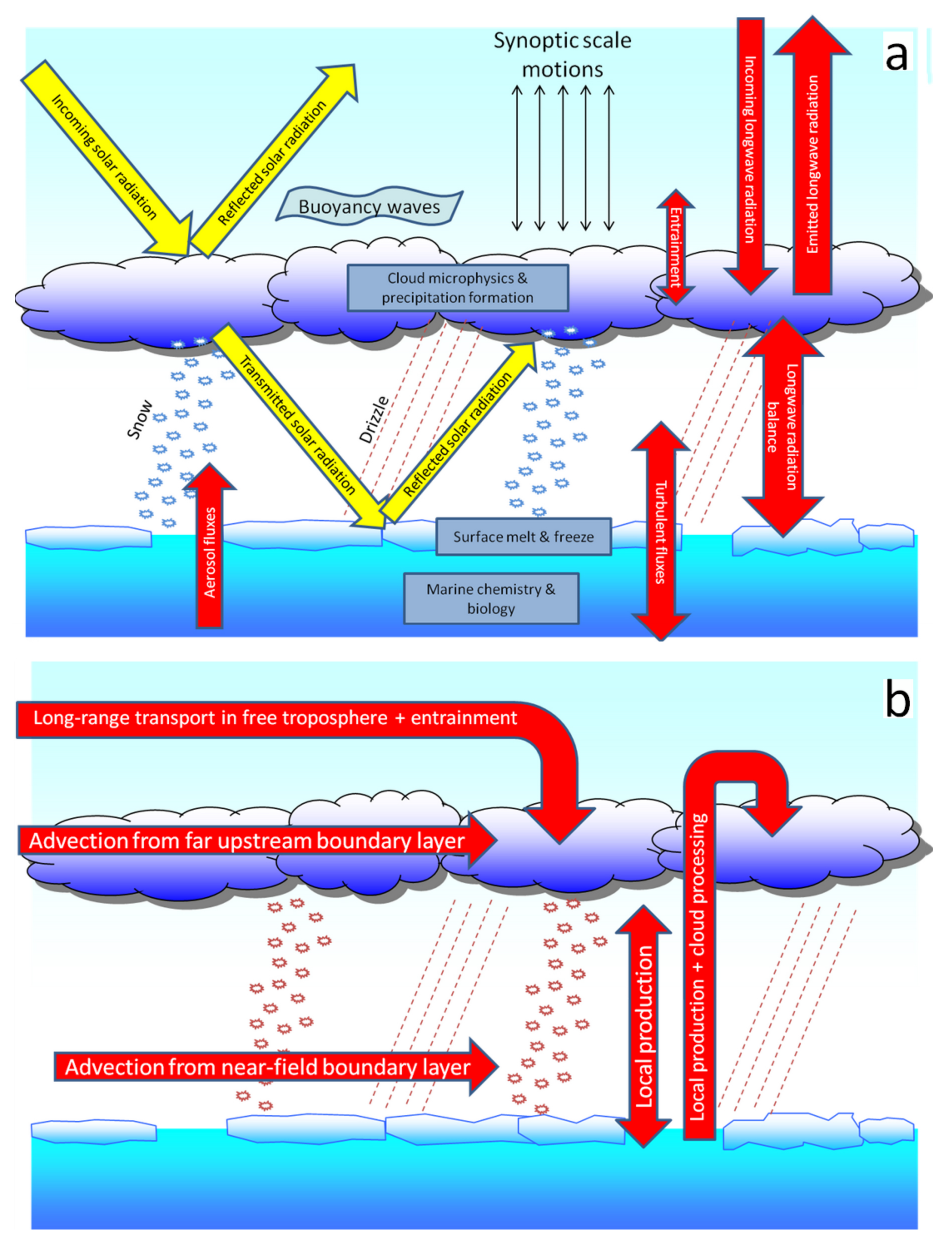
Fig. 2. Schematic description of processes that are necessary to observe in order to understand the formation and life cycle of Arctic low-level clouds, illustrating (a) the processes at play and (b) specifically the aerosol formation